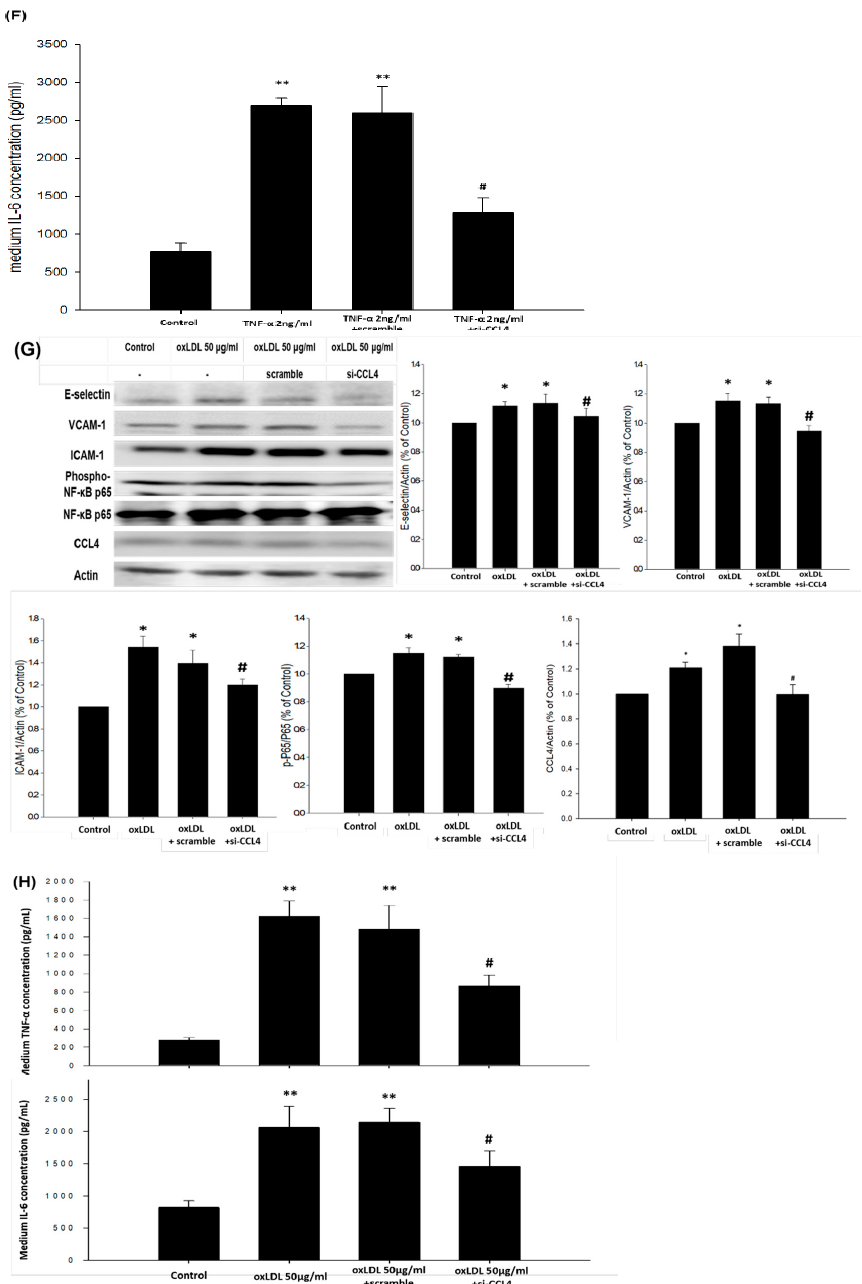
Figure 6. Inhibition of the endogenous CCL4 reduced TNF- α - and ox-LDL-induced adhesion and inflammation protein expressions in HCAECs and macrophages. Western blots and statistical analyses of E-selectin, VCAM-1, and ICAM-1 expressions in HCAECs after the stimulation of TNF- α ( n = 3; A ) and ox-LDL ( n = 3; C ) for 24 h. TNF- α and IL-6 levels in the culture medium of HCAECs after the stimulation of TNF- α ( n = 6; B ) and ox-LDL ( n = 6; D ) were determined using ELISA kits. Western blots and statistical analyses of adhesion molecules and the nuclear factor kappa B-p65 (NF- κ B) signaling pathway in macrophages after the stimulation of TNF- α ( n = 3; E ) and ox-LDL ( n = 3; G ) for 24 h. TNF- α and IL-6 levels in the culture medium of macrophages after the stimulation of TNF- α ( n = 6; F ) and ox-LDL ( n = 6; H ) were determined using ELISA kits. N represents for the number of independent experiments. * p < 0.05, ** p < 0.01 compared with the control group. # p < 0.05, ## p < 0.01 compared with the TNF- α - or ox-LDL-stimulated